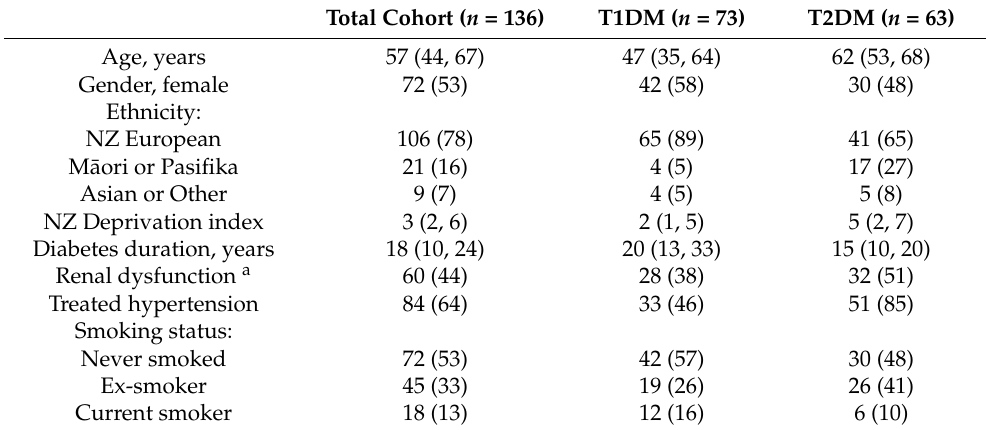
Table 1. Participant characteristics.